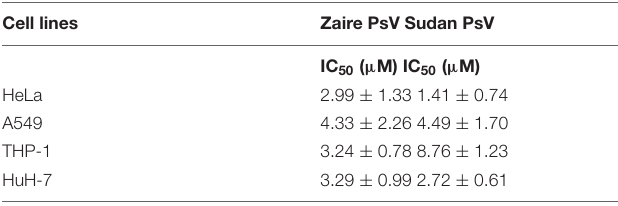
TABLE 1 | Entry-inhibitory activity of tolcapone against Zaire PsV and Sudan PsV in various cell lines a . Cell lines